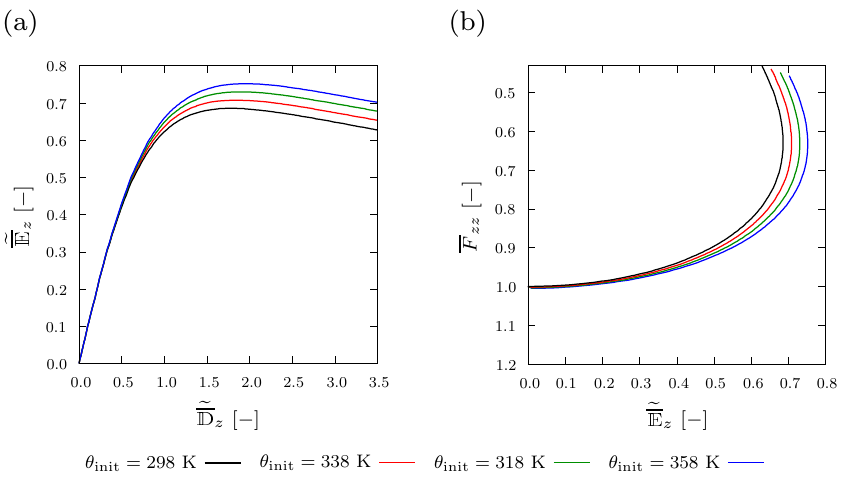
Figure 5. Plot of ( a ) averaged and normalized electric displacement (cid:101) D z [ − ] and ( b ) averaged defor- mation F zz [ − ] versus averaged and normalized electric field (cid:101) E z [ − ] with varying applied initial temperature θ init = { 298, 318, 338 and 358 Kelvin }